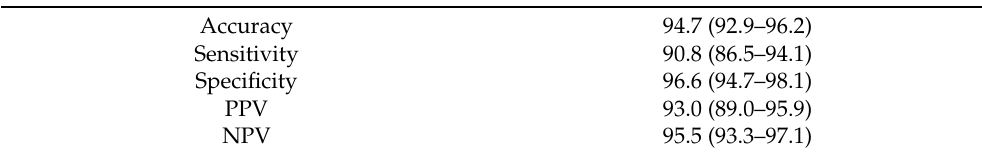
Figure 3. Receiver-operating characteristic curve. Table 2. Diagnostic accuracy for each image. Table 2. Diagnostic accuracy for each